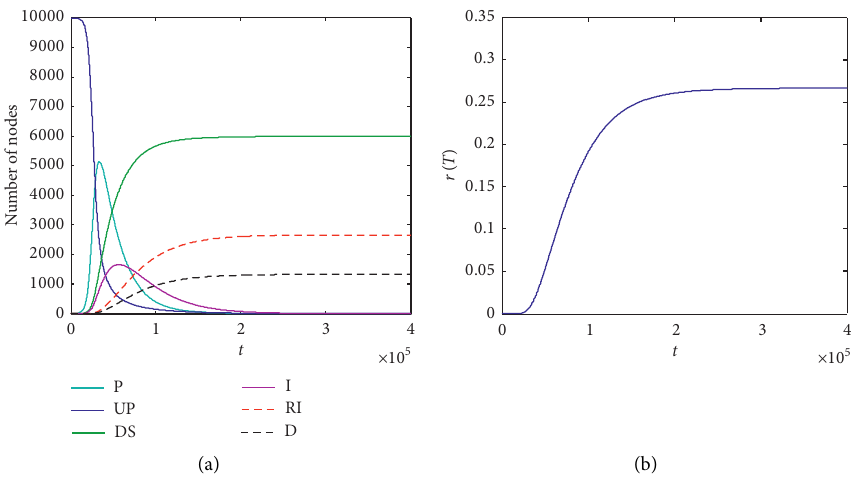
Figure 2: (a) The number of nodes in the six states versus time with T � 4 × 10 5 s. (b) The proportion of regular investor nodes against time. Other parameters are set as follows: α � 1 × 10 − 7 , β � 3 × 10 − 5 , c � 2 × 10 − 5 , μ � 1 × 10 − 5 , λ � 2 × 10 − 5 , T � 4 × 10 5 , Q � 0.3, C i ∼ N (0.9, 0.1 2 ), K � 5.